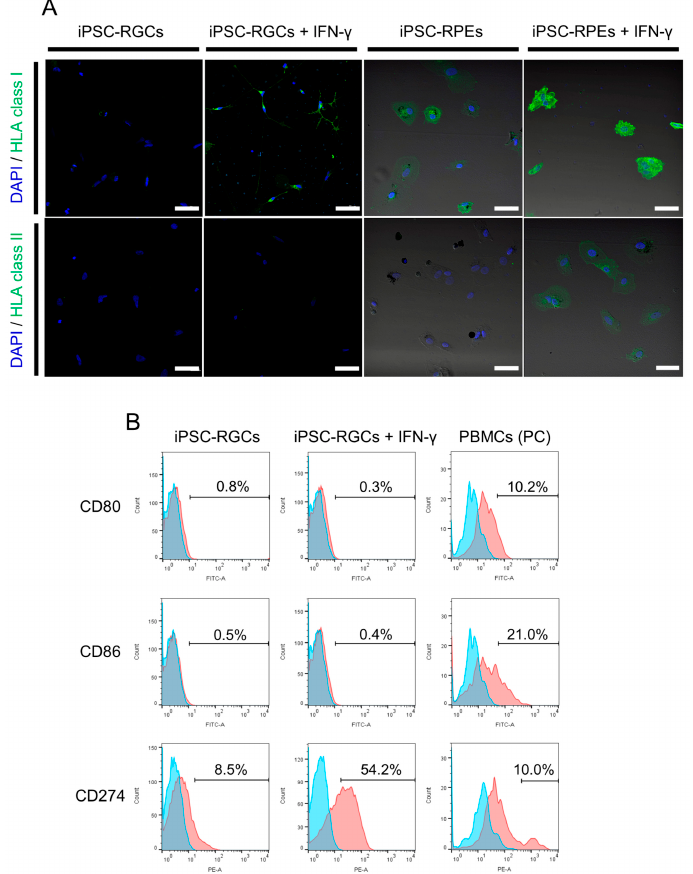
Figure 3. Expression of HLA class I, class II, and co-stimulatory molecules on human iPSC-RGCs. ( A ) Expression of HLA class I (green) and class II (green) on iPSC-RGCs was assessed with ICC. iPSC- RPEs were used as control cells. HLA class I was poorly expressed on iPSC-RGCs and was enhanced, but slightly, on IFN- γ -treated iPSC-RGCs. HLA class II was not expressed on iPSC-RGCs with or without IFN- γ pre-treatment. Cell nuclei were counterstained with DAPI (blue). Scale bars, 50 µm. ( B ) Expression of co-stimulatory molecules, CD80 (B7-1), CD86 (B7-2), and CD274 (PD-L1:B7-H1), was assessed with fluorescence-activated cell sorting analysis. CD80 and CD86 co-stimulatory molecules were not expressed on iPSC-RGCs with or without IFN- γ (red histograms). CD274 co-stimulatory molecules were slightly expressed on iPSC-RGCs and were enhanced on IFN- γ -treated iPSC-RGCs (red histograms). We also prepared PBMCs as positive control (PC) cells. Numbers in the histograms indicate the percentage of positive cells. Blue histograms represent the isotype control.